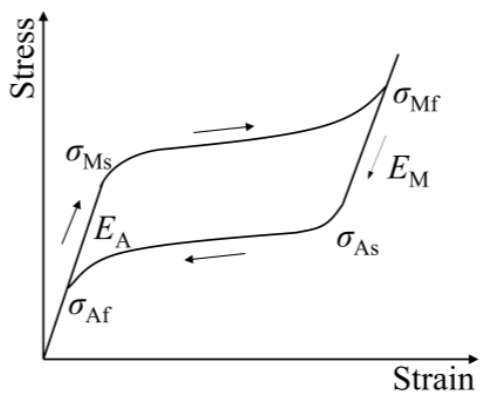
Figure 1. Principal structure relationship diagram of shape memory alloy: the arrows indicate the direction of martensitic transformation.